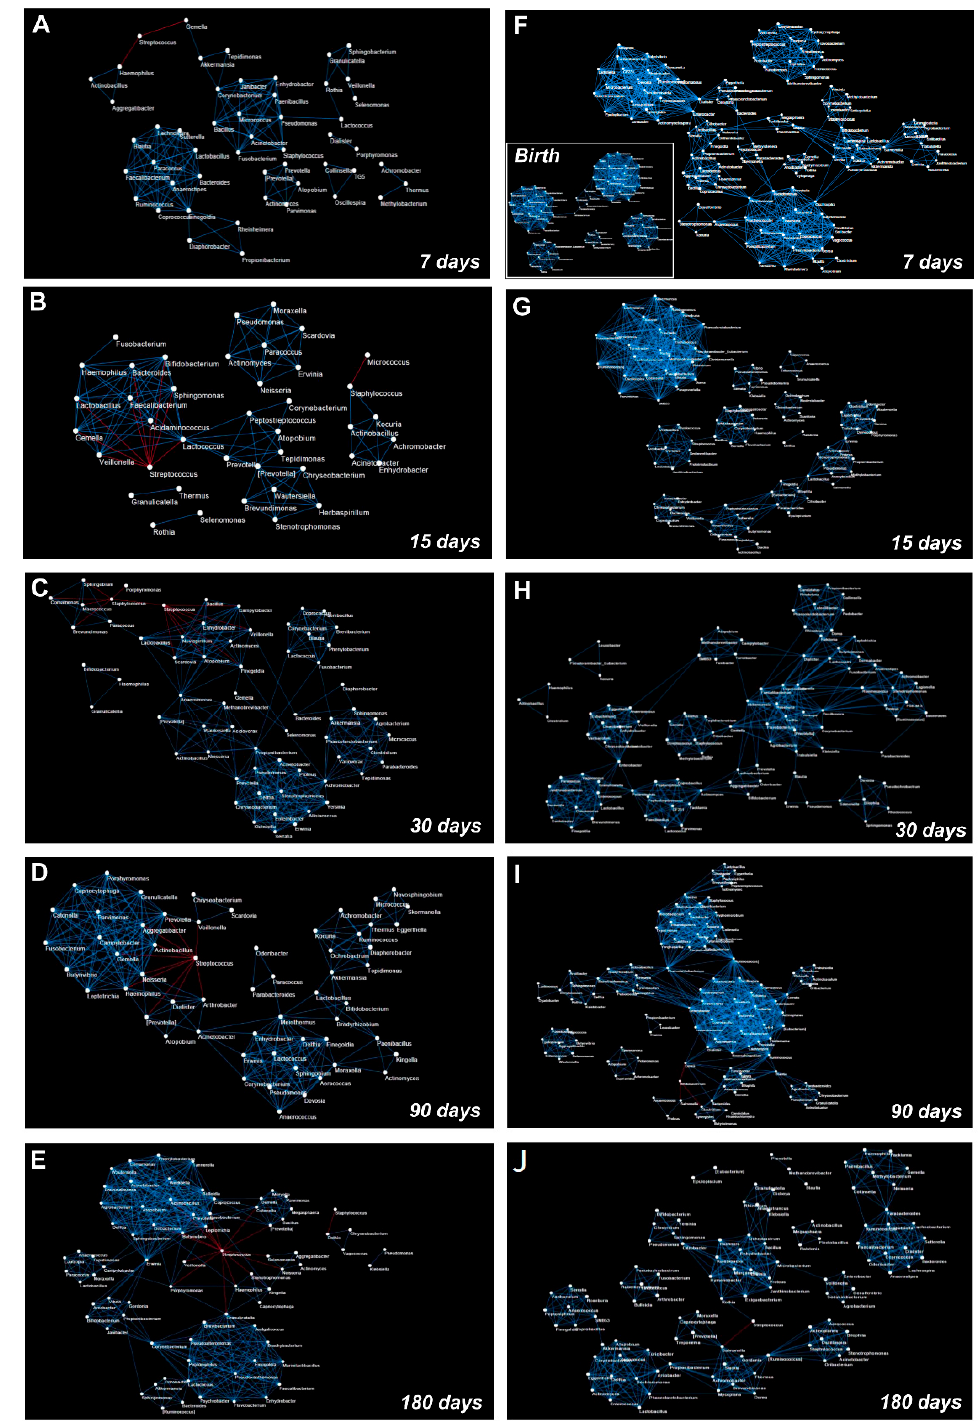
Figure 6. Graphical representation of the OTUs co-occurrence networks. The panels represent OTUs co-occurrence networks of saliva ( A – E ) and stool ( F – J ) samples that were analyzed at days 7, 15, 30, 90, and 180 following birth, respectively. The co-occurrence network that was obtained from meconium samples is represented as an inset within panel ( F ). The blue line indicates a positive correlation and a red line indicates a negative correlation. A Pearson’s test was used to evaluate the correlation amongst the OTUs (statistical significance was assessed with p FDR <